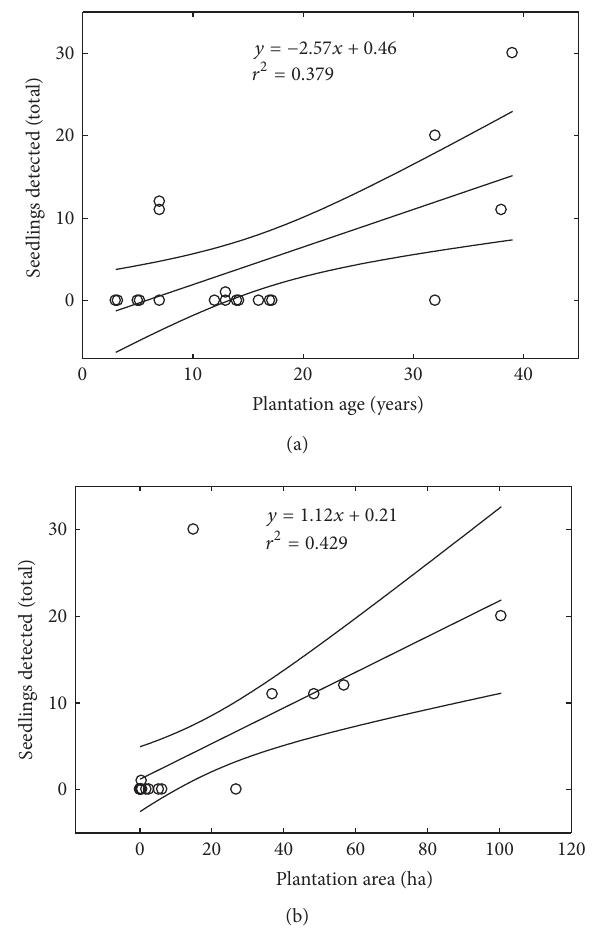
F 4: Relationship between (a) the age of the oldest trees planted at each plantation, and Eucalyptus seedling establishment; and(b)sizeoftheplantationand Eucalyptus seedlingestablishment. Because some plantations were very similar in size and also had few or no seedlings established, some points on the graph will overlap withsomebeingobscured.�on�denceintervalsare�5 %